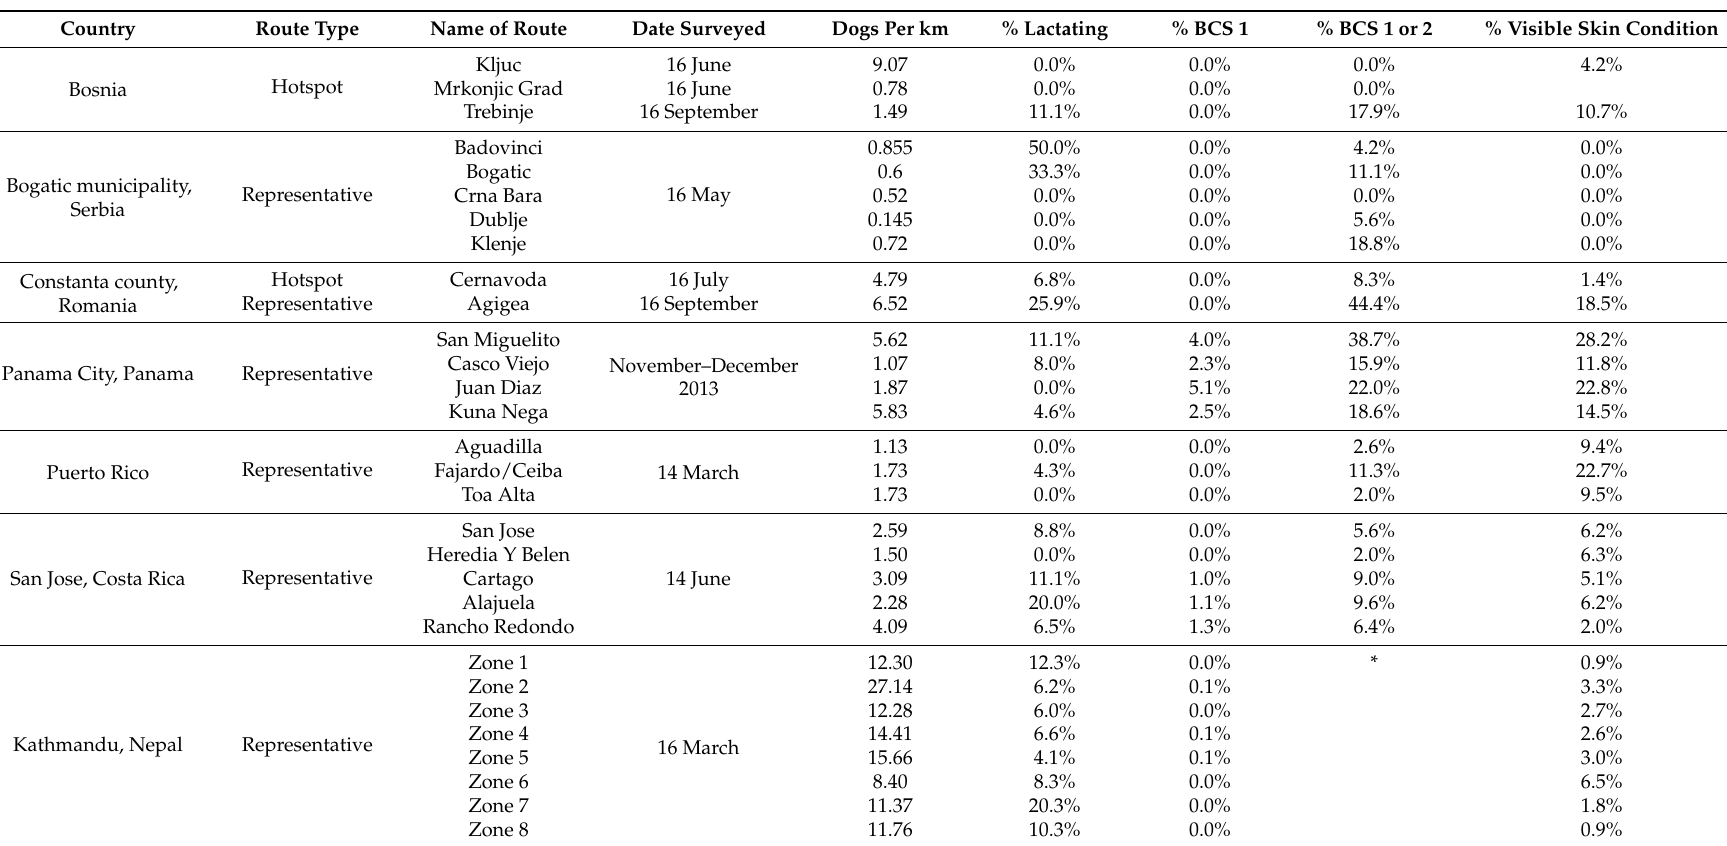
Table 1. Indicators relating to density, reproductive activity and welfare of roaming dogs for two or more routes in seven locations; resulting from application of the method of direct observation of dogs along public streets. BCS, body condition